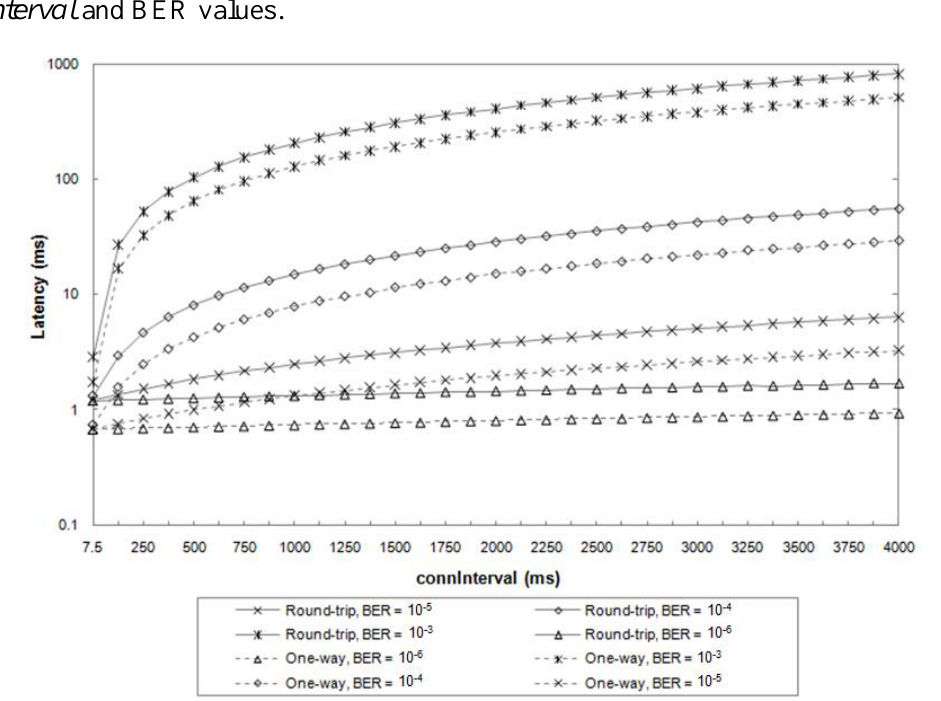
Figure 6. Average latency for one-way and round-trip message exchanges, for various connInterval and BER